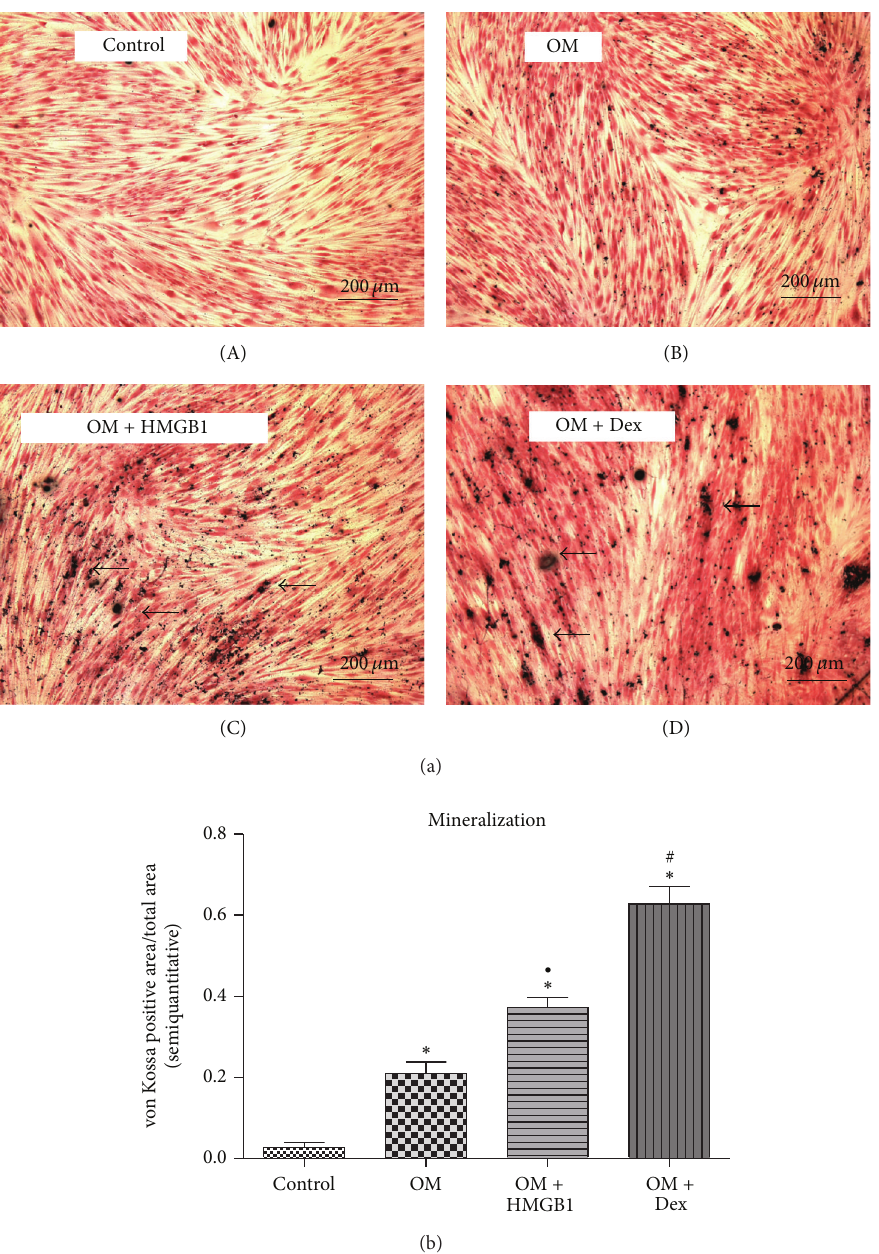
Figure 6: HMGB1 stimulation influences PDL cell mineralization. HMGB1 exposure of hPDL cells for 21d resulted in enhanced biomineralization (a). In the absence of a respective substrate, no mineralized nodule formation was observed (A), whereas osteogenic medium (OM) itself (B) as well as OM supplemented with HMGB1 (C) led to the formation silver nitrate positive areas (arrows), which were most evident and spread in dexamethasone treated cultures (D). The semiquantitative assessment of mineralized area versus total area revealed confirming results (b). Data represent the mean ± SD for six independent cultures. ∗ 𝑃 < 0.05 , experimental group versus untreated control; # 𝑃 < 0.05 , dexamethasone treated group versus HMGB1 treated cultures; ∙ 𝑃 < 0.05 , HMGB1 treated cultures versus osteogenic medium